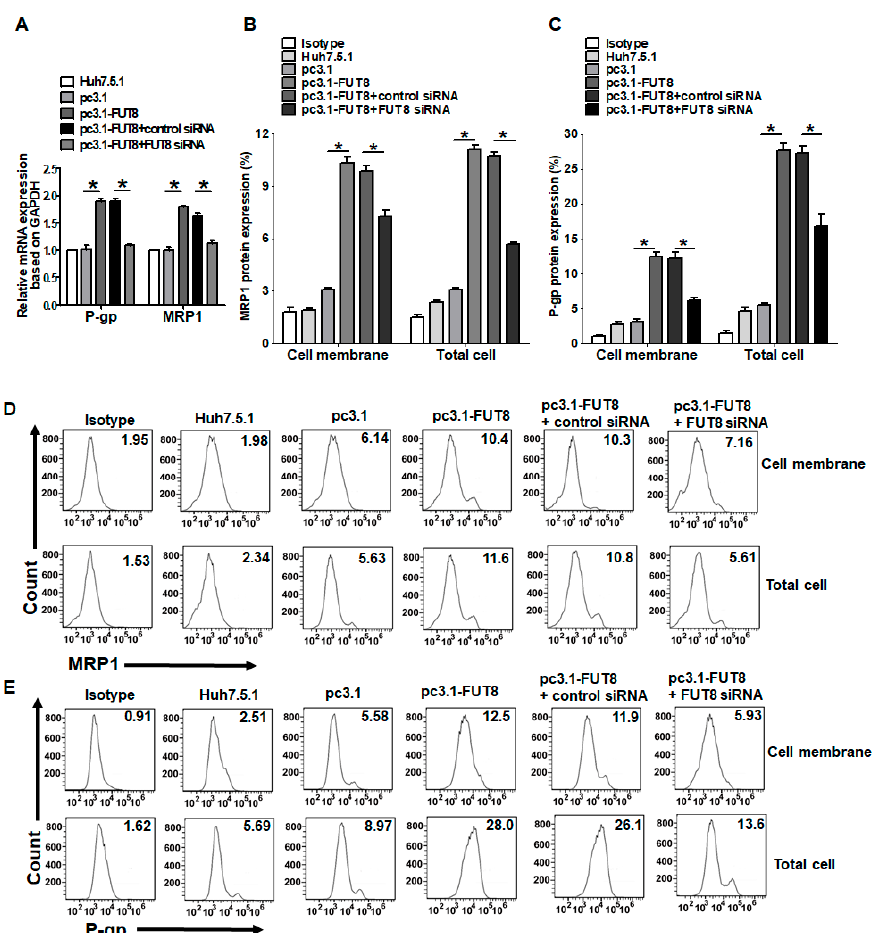
Figure 6. Effects of overexpression of FUT8 on the expression of multidrug resistance-associated proteins. ( A ) Statistical analysis of qRT-PCR of the mRNA expression of MRP1 and P-gp after FUT8 transfection in Huh7.5.1 cells with or without knockdown of FUT8. Statistical analysis of flow cytometry data for the expression of MRP1 ( B ) and P-gp ( C ) after FUT8 transfection in Huh7.5.1 cells. ( D , E ) Representative data of flow cytometry analysis for the expression of MRP1 ( D ) and P-gp ( E ) in Huh7.5.1 cells after stimulation with HCV infection. * p < 0.05.